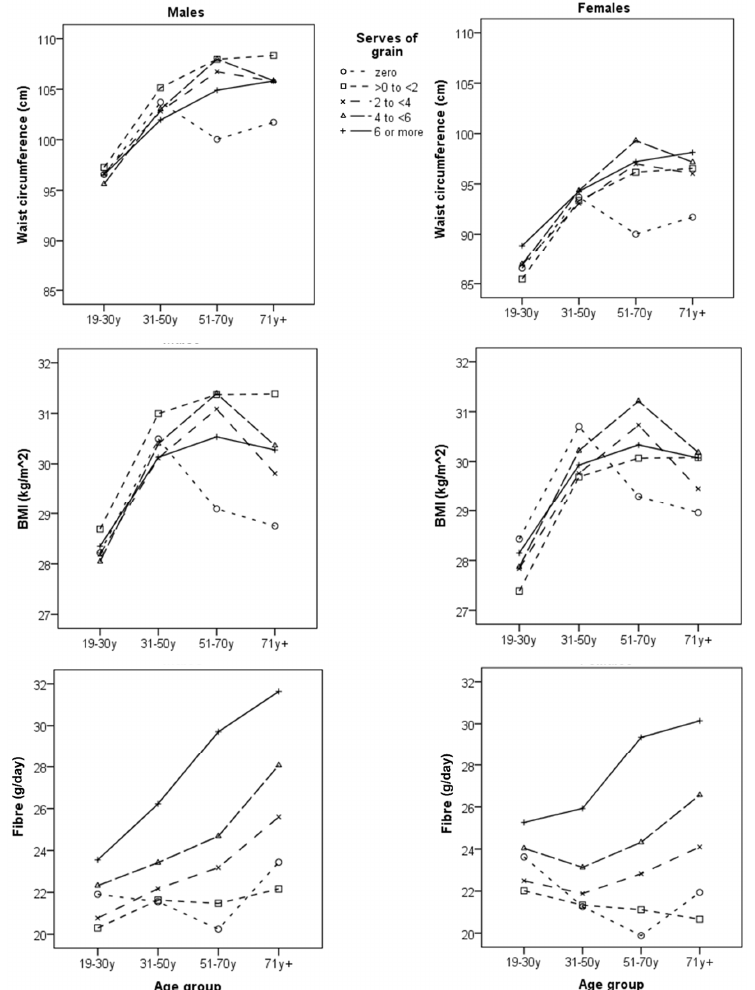
Figure 1. Estimated marginal means from models for waist circumference, BMI and fibre by age groups and sex (Model 3). Covariates in the models evaluated at energy intake (MJ) = 8.8, usual fruit intake serves = 1.62, usual vegetable intake serves = 2.36, percent of energy that is discretionary (%) =